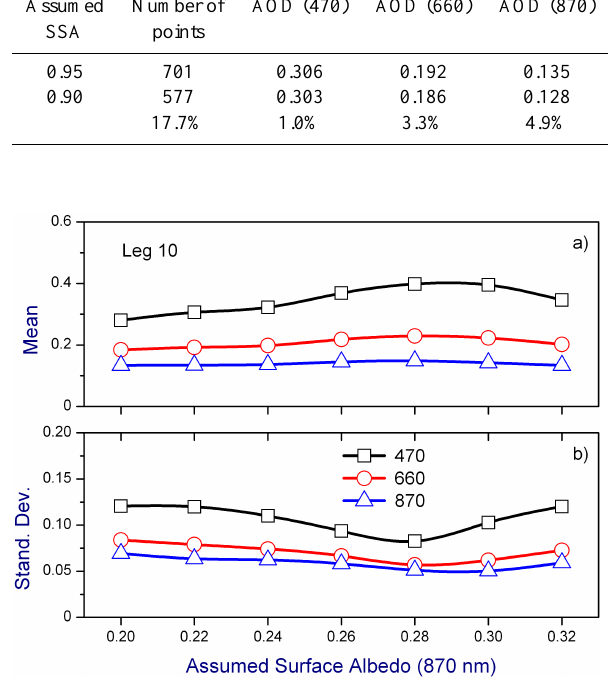
Fig. C1. Mean values of the RR-retrieved AOD (leg 10) at three wavelengths (470, 660 and 870nm) (a) and the corresponding val- ues of standard deviation obtained for seven cases with different assumptions about surface albedo at